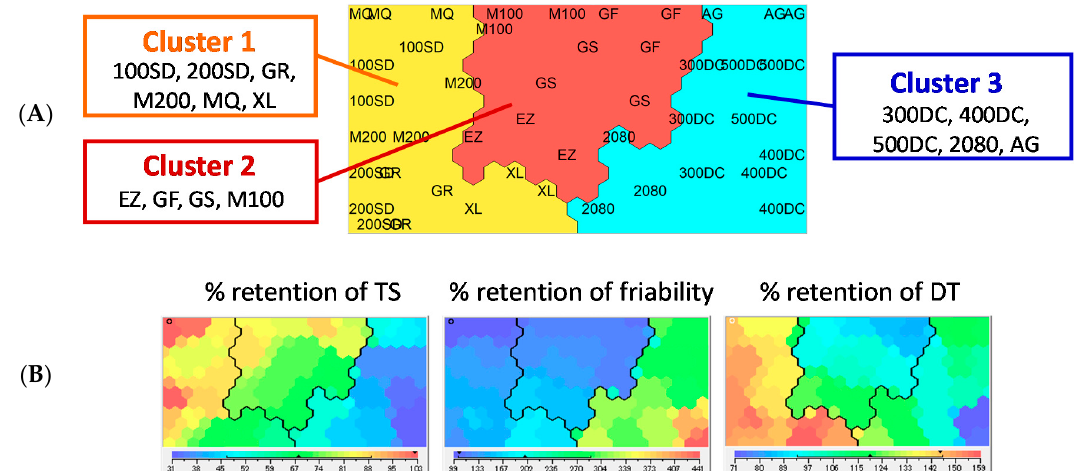
Figure 3. ( A ) SOM and ( B ) SOM feature maps to classify test grades of mannitol according to the storage stability of tablet properties. The SOM clustering was performed using % retention of TS, friability, and DT of tablets having 55, 65, and 75 N of hardness as training variables. Each experimental data set was labeled on the nodes of the map to express the data distribution ( A ). The properties of the tablets having 65 N of hardness are shown in the SOM feature maps as a representative variable ( B ).